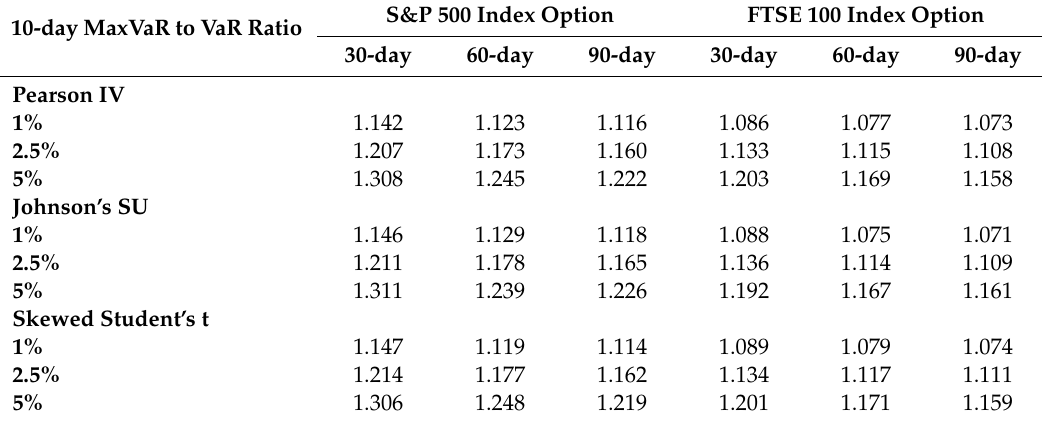
Table 6. Average 10-day Inflation factor.